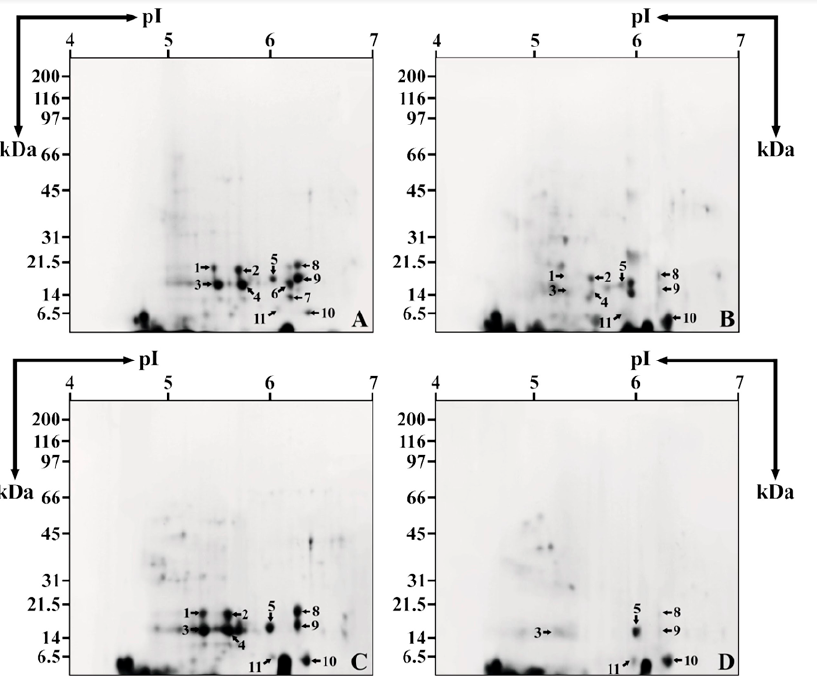
Figure 5. 2 D-PAGE separations of the albumin fraction (( A )—cv. Nadwi ś la ń ski seeds stored at − 14 Figure 5. 2D-PAGE separations of the albumin fraction (( A )—cv. Nadwi´sla´nski seeds stored at − 14 ◦ C; °C; ( B )—cv. Nadwi ś la ń ski seeds after +20 °C storage; ( C )—cv. Dino seeds stored at − 14 °C; ( D )—cv. ( B )—cv. Nadwi´sla´nski seeds after + 20 ◦ C storage; ( C )—cv. Dino seeds stored at − 14 ◦ C; ( D )—cv. Dino Dino seeds stored at +20 °C). seeds stored at + 20 ◦